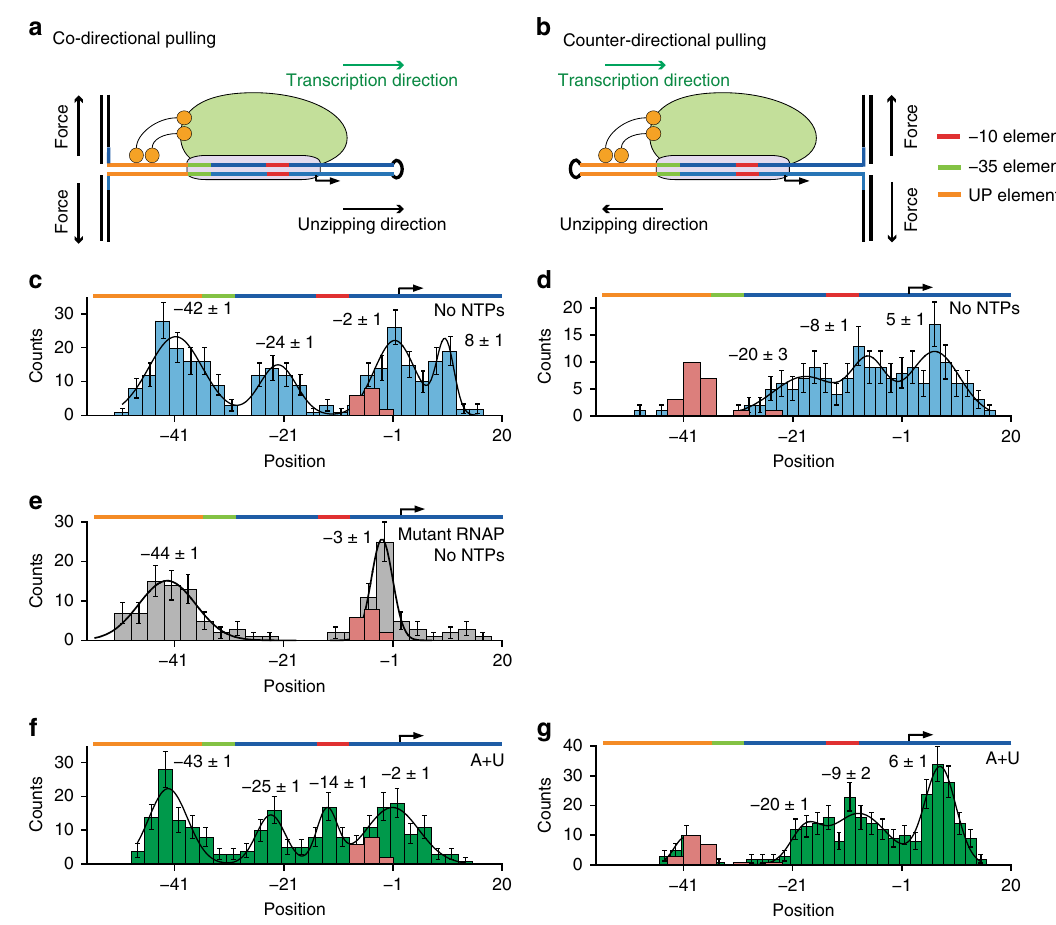
Fig. 2 Mapping RNAP holoenzyme-promoter contacts. a , b Cartoon illustrating the assay geometry. A hairpin stem bearing the T7A1 promoter, extending from positions − 56 to +20, was used for both co-directional and counter-directional studies, with a tetraloop (black) at one end and dsDNA handles attached to other. RNAP (green ellipse) with σ 70 (purple) recognizes the promoter, including the − 10 (red), − 35 (green), and UP (orange) elements, and initiates transcription from the TSS (right-angle arrow). Optical forces can be applied to break RNAP-promoter contacts in either transcriptional direction. c , d , f , g Mapped distributions of the “ rip ” positions for wild-type RP o , with (green) or without (blue) ATP + UTP present. Hairpin intermediate states are also shown (pink). The promoter axis (colored) is shown on top for reference. e Mapped distributions of rips with a strand-opening-de fi cient mutant